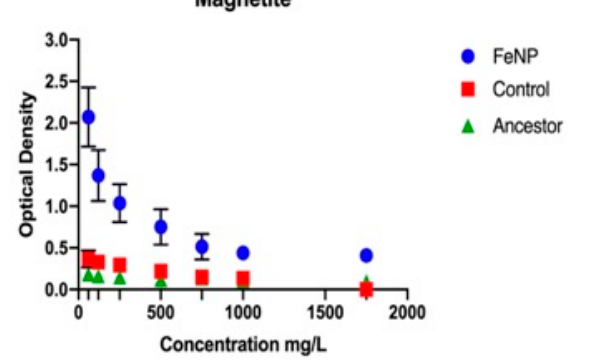
Figure 1. The mean and SE of 24 h growth for FeNP, Control, and Ancestral populations in increasing concentration of Magnetite NPs are shown. There was no observable growth at 2000 mg/mL magnetite for the FeNP population.